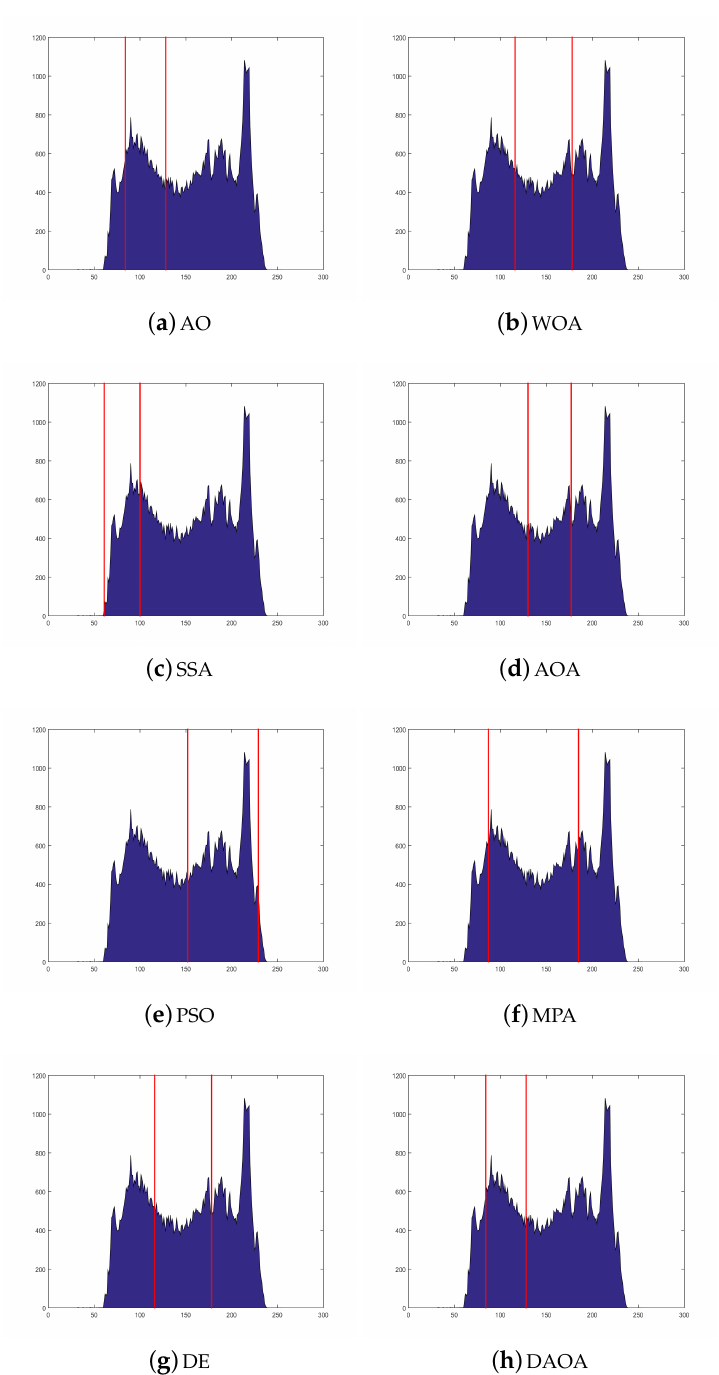
Figure 11. The histogram image (Test 8) by the comparative methods when the threshold value is